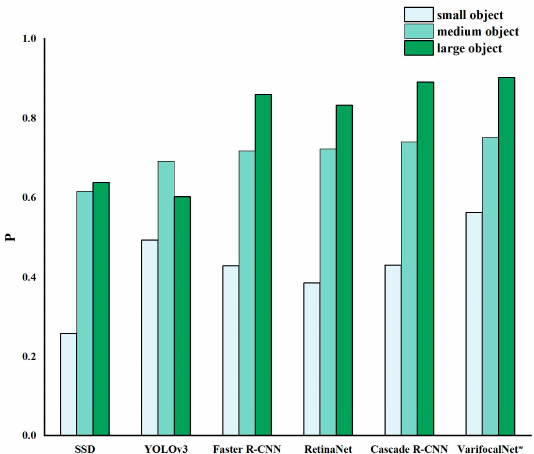
Figure 11. Comparison of different competing methods in detection accuracy of large, medium, and small objects.